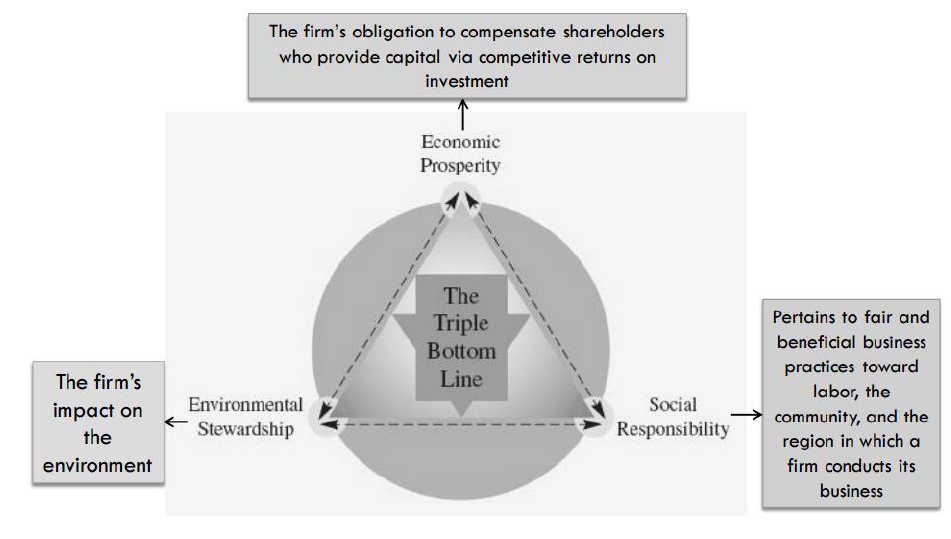
Figure 3: The Triple Bottom Line